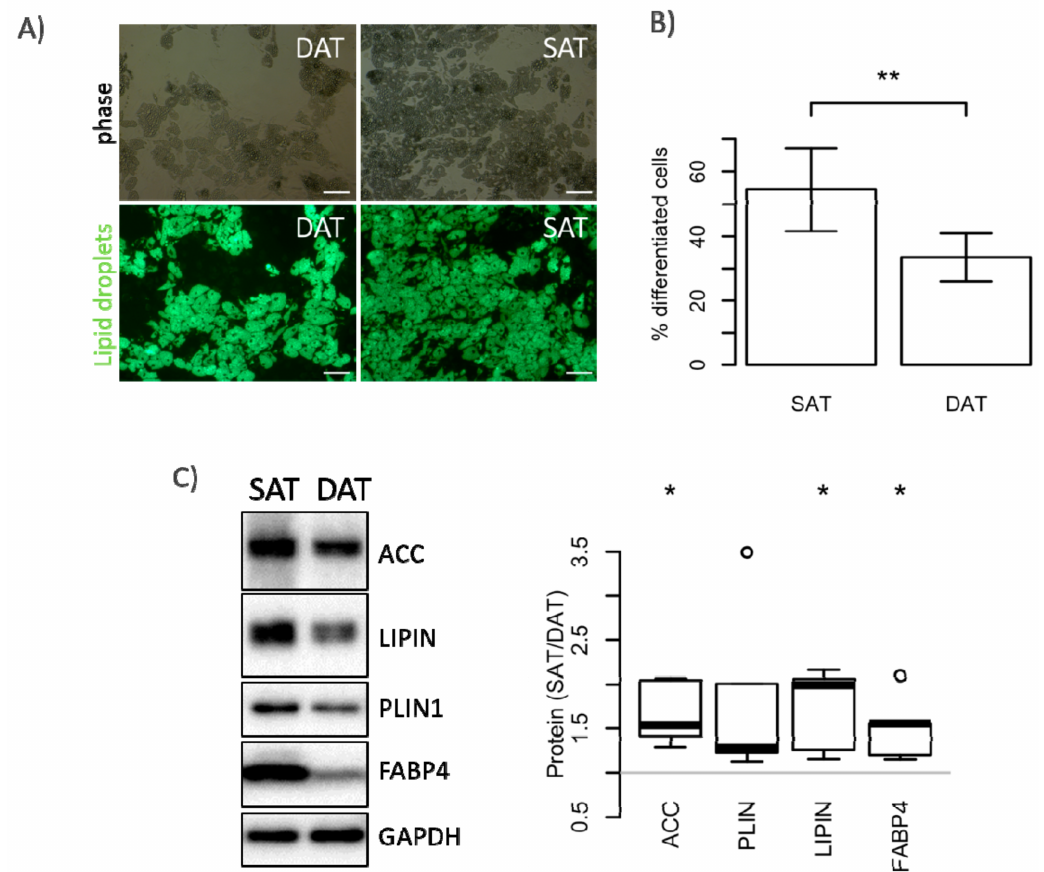
Figure 3. Adipocyte differentiation potential of SAT- and DAT-derived ASC. ASC isolated from SAT and DAT were differentiated in vitro for 14 days. BODIPY™ 493/503-stained adipocytes were analysed by fluorescence microscopy ( A ) and quantitatively assessed by flow cytometry ( B ); Size bar: 100 µ m. Data are shown as mean ± SD ( n = 6), significance for difference of the means calculated with a paired t -test (** p -value < 0.01); ( C ) Representative immunoblot and quantitative assessment of day 14 differentiated ASC from five donors, analysing expression of acetyl-CoA carboxylase (ACC), lipid-droplet-binding protein perilipin 1 (PLIN1), phosphatidate phosphatase lipin 1 (LPIN1), fatty acid transport protein 4 (FABP4), and GAPDH as loading control. Results are shown as box plots representing the distribution of fold change values; significance of the fold change was assessed by testing against the null hypothesis of a mean fold change of 1 (* p -value <